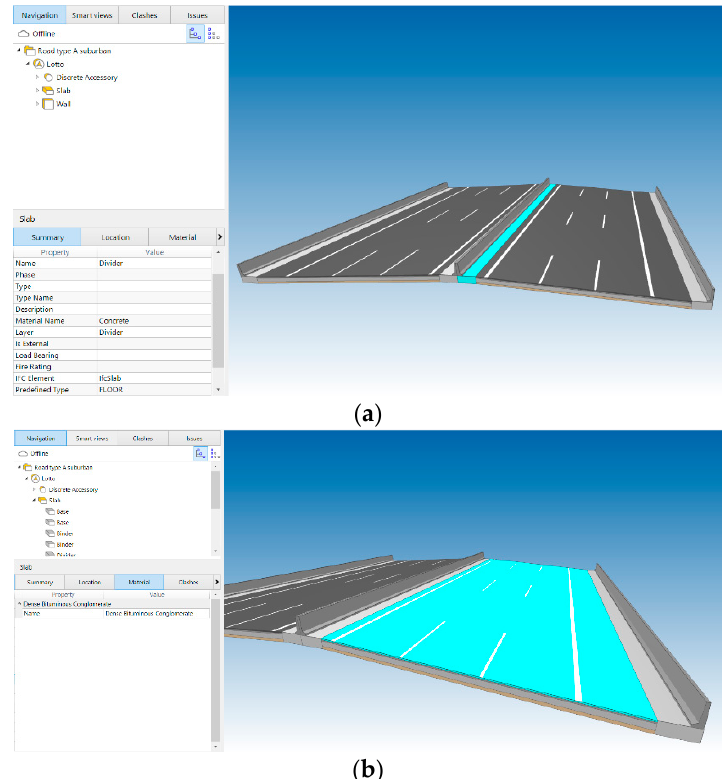
Figure 7. Visualization of the IFC Road model exported from Rhinoceros/VisualARQ in the BIMcollab ZOOM viewer. ( a ) Information about the road divider; ( b ) Material information for the road surface course.